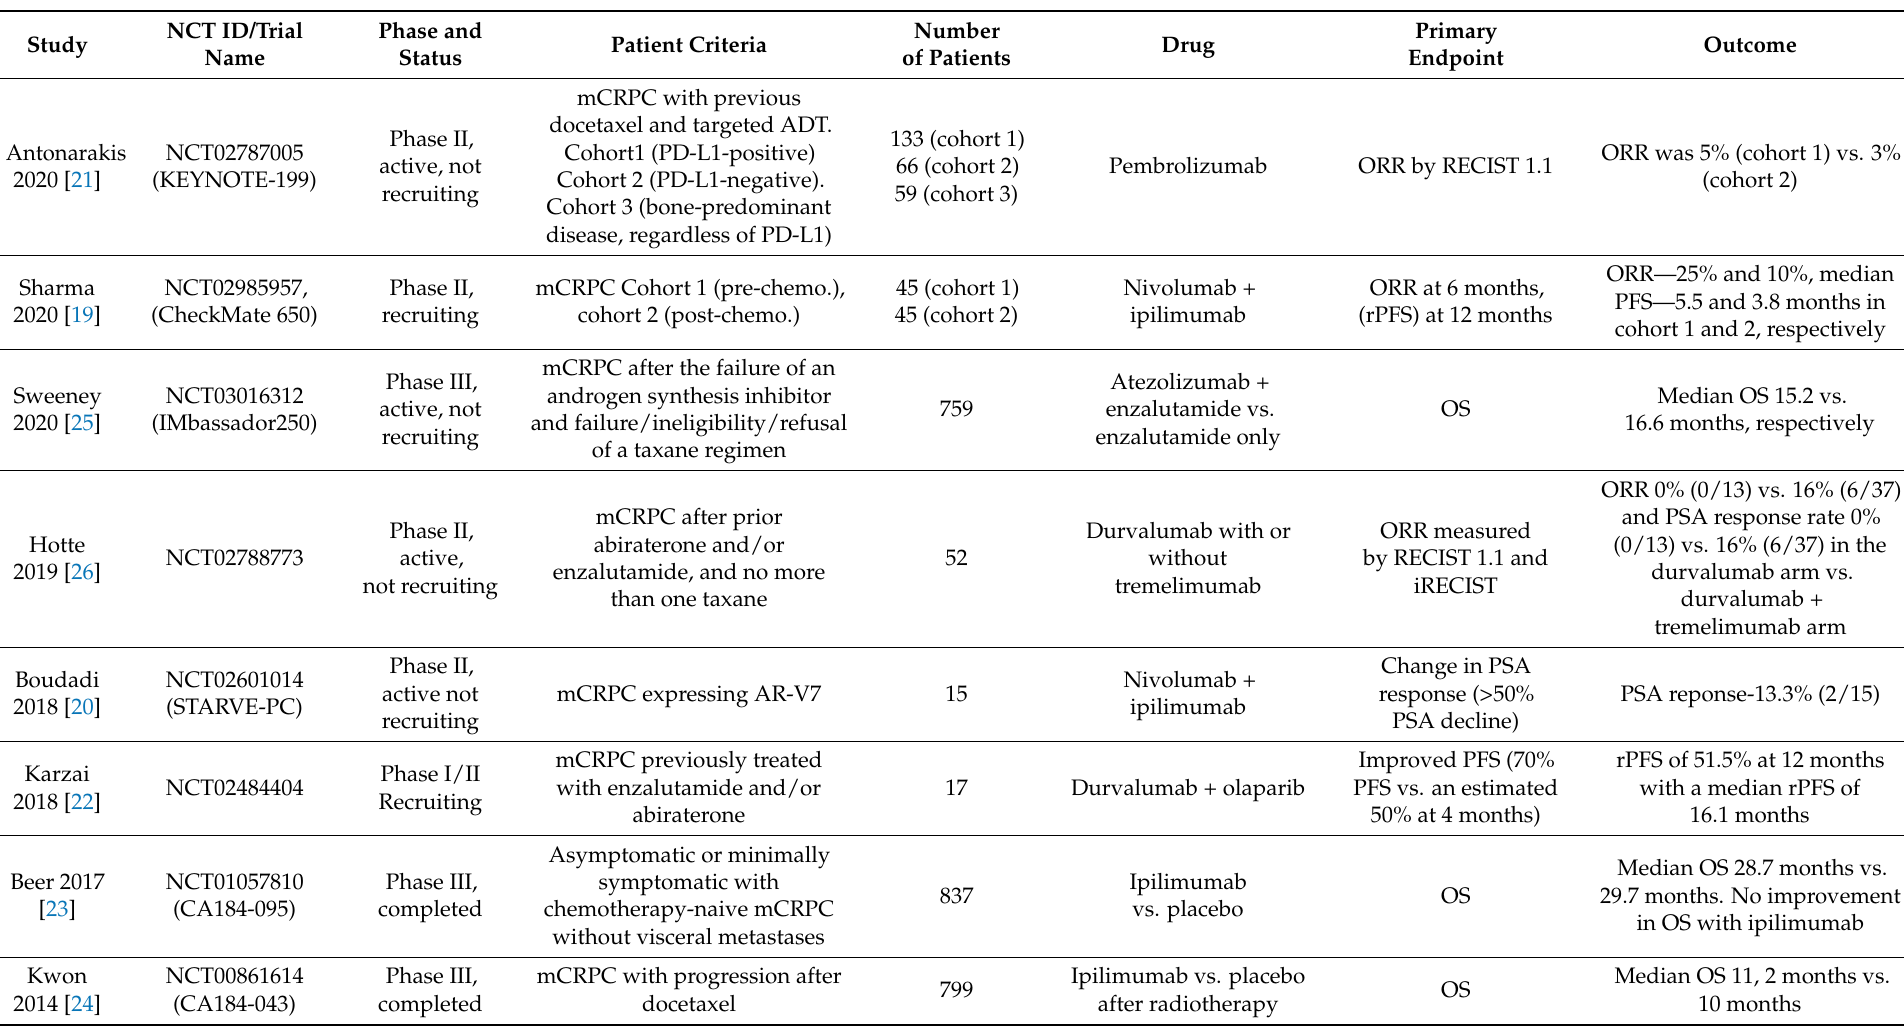
Table 1. Summary of the included studies. mCRPC, metastatic castration-resistant prostate cancer; ADT, androgen deprivation therapy; ORR, overall response rate; PSA, prostate-specific antigen; RECIST, response evaluation criteria in solid tumors; OS, overall survival; PD- L1, programmed death ligand